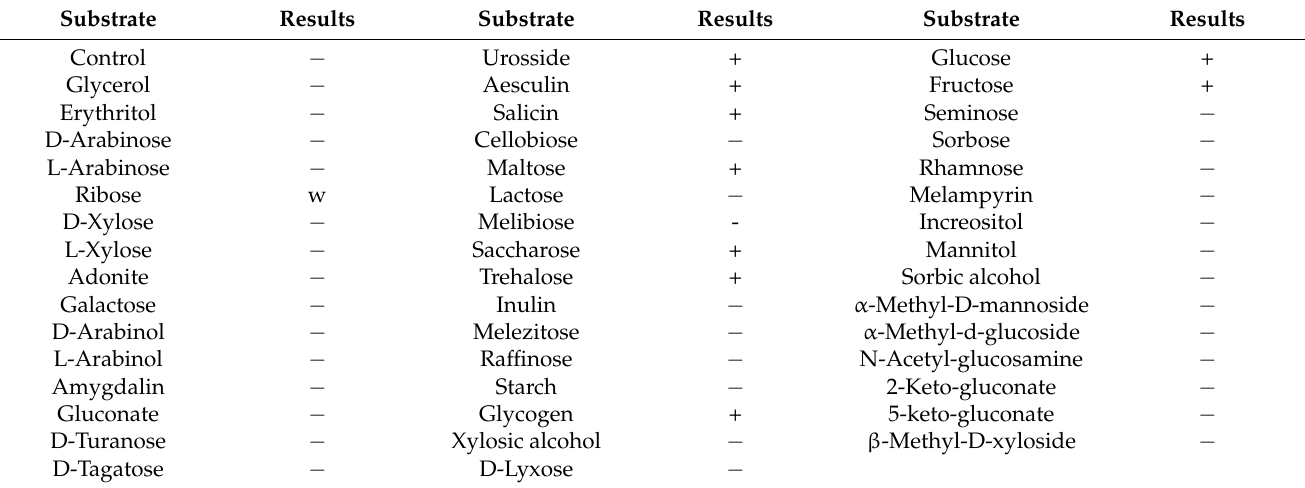
Table A4. Physiological and biochemical characteristics of strain AH7-7 in the API50CH identifica- tion